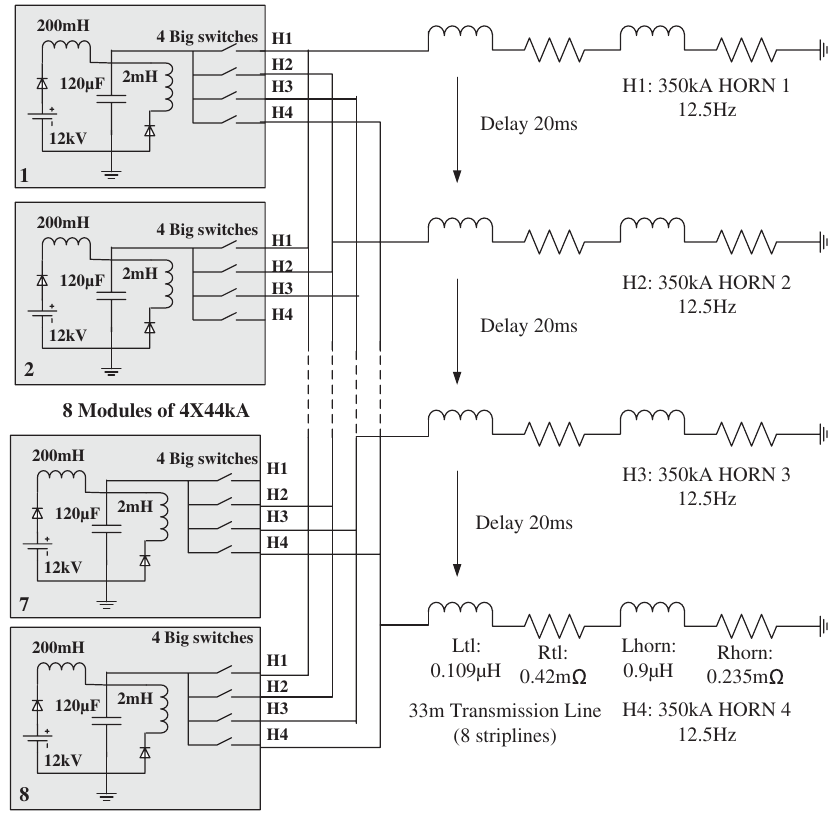
FIG. 23. Modular architecture of the horn ’ s power supply.